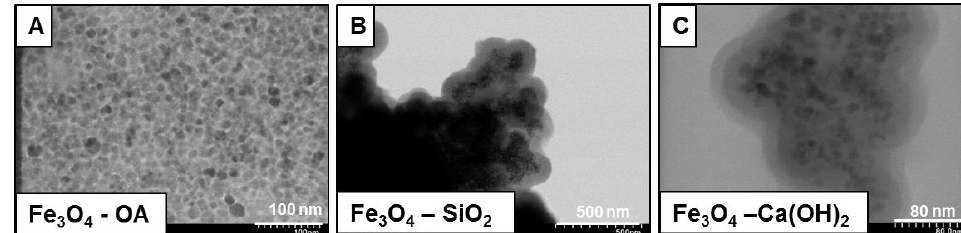
Figure 1. The morphology of magnetic dental composite materials (TEM images): ( A ) Fe 3 O 4 -OA, hydrophobic magnetic nanoparticles, covered with oleic acid; ( B ) Fe 3 O 4 -SiO 2 , magnetic composite, covered with SiO 2 layer; ( C ), Fe 3 O 4 -Ca(OH) 2 , final magnetic dental composite material, covered with a layer of Ca(OH) 2